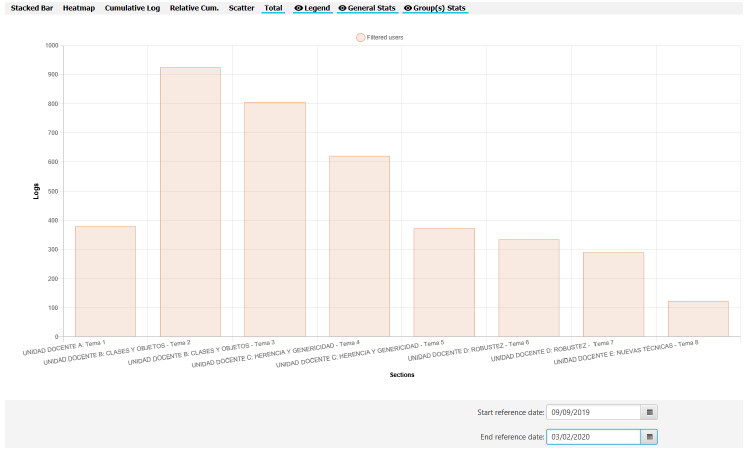
Figure 10. Total accesses by sections.